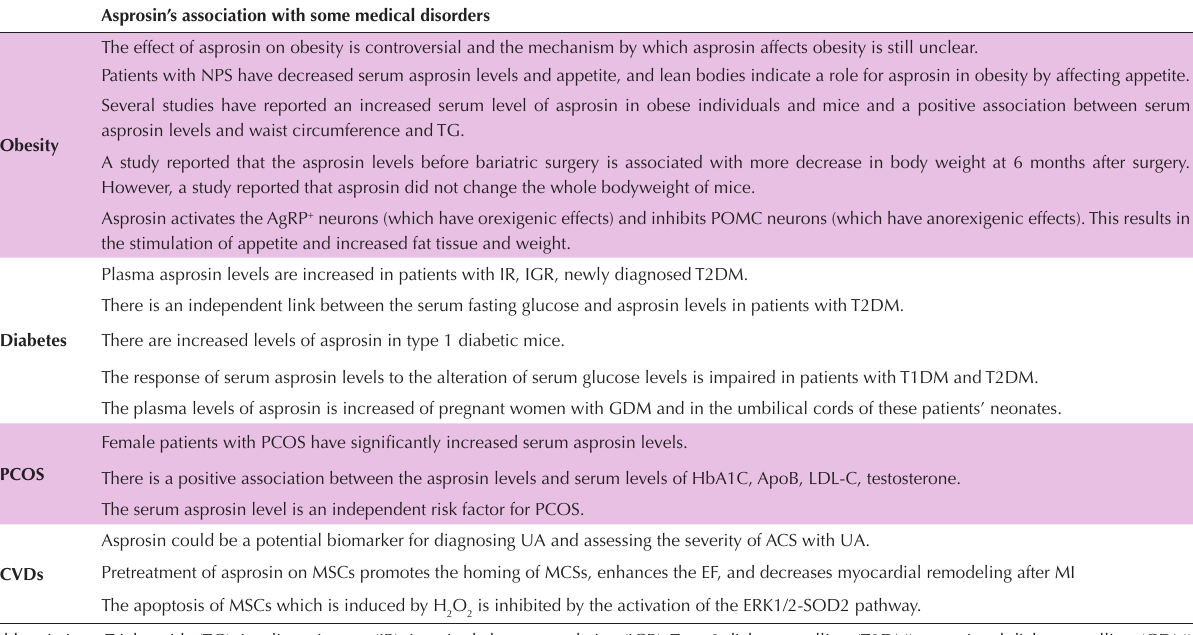
Table 2. Asprosin’s association with some medical disorders (1-4,7,10,13-21) Asprosin’s association with some medical disorders